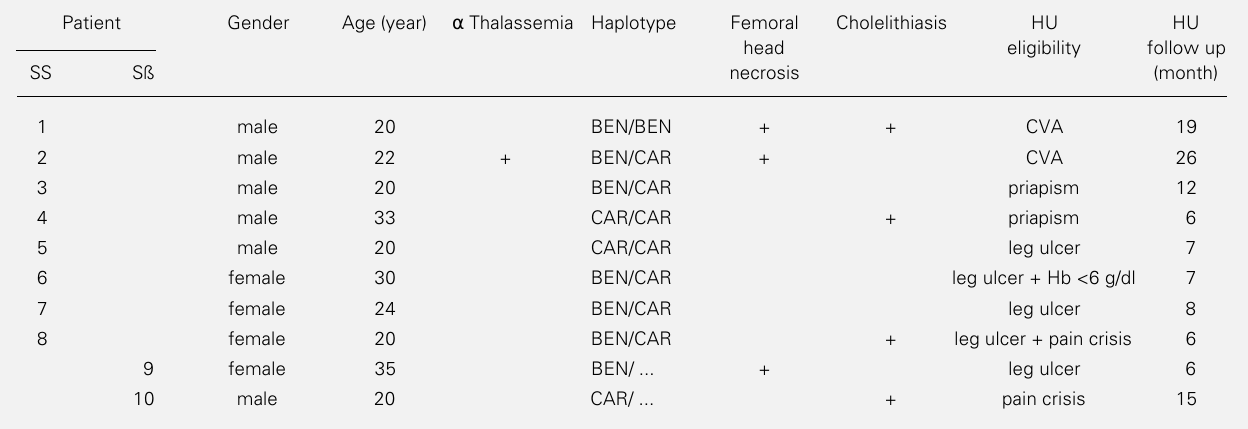
Table 1 - Clinical and laboratory characteristics of sickle cell patients undergoing hydroxyurea (HU) treatment.